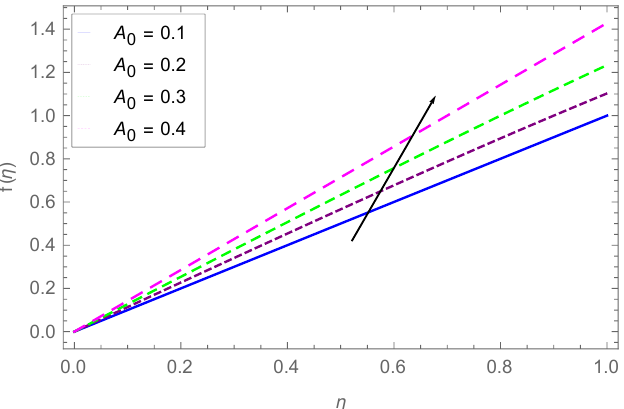
Figure 14. Plot depicting f ( η ) dependence on A 0 .